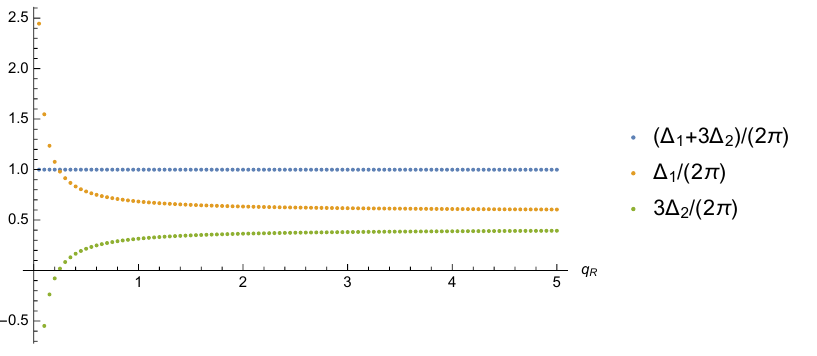
Figure 3 . Numerical values of the chemical potentials ˆ∆ 1 and ˆ∆ 2 normalized by 2 π for Case 1 as a function of q R . Also the combination ˆ∆ 1 + 3 ˆ∆ 2 is shown which is expected to be equal to 2 π . same value for z (0) = 1